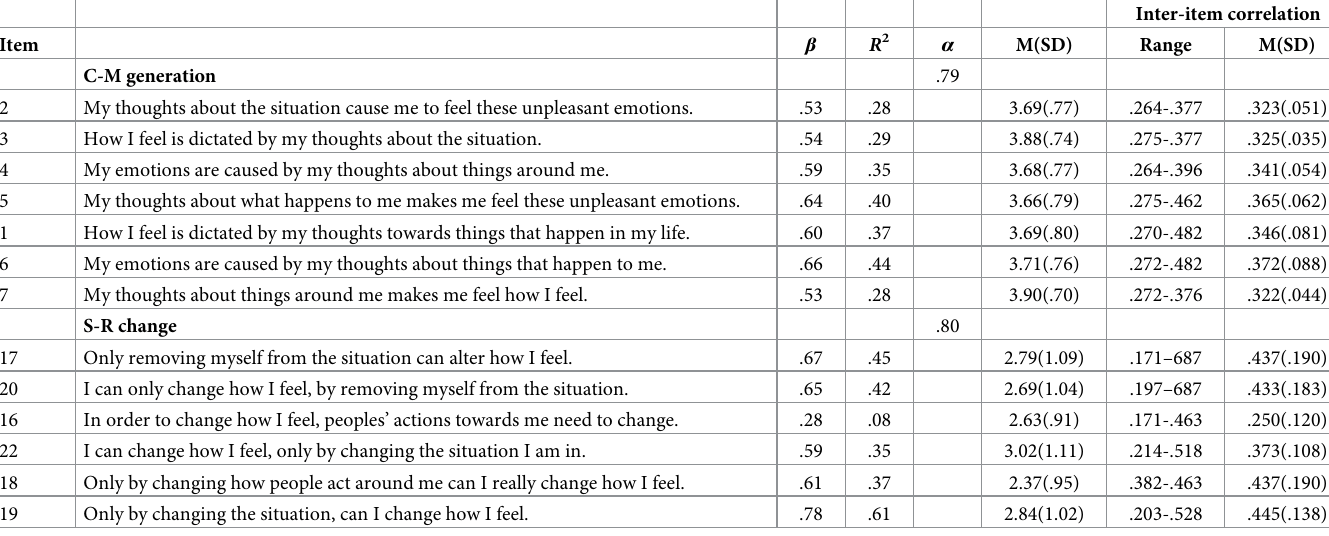
Table 2. Item properties, internal consistency, inter-item correlations, and descriptives, of the 13-item CMBQb in study 3.